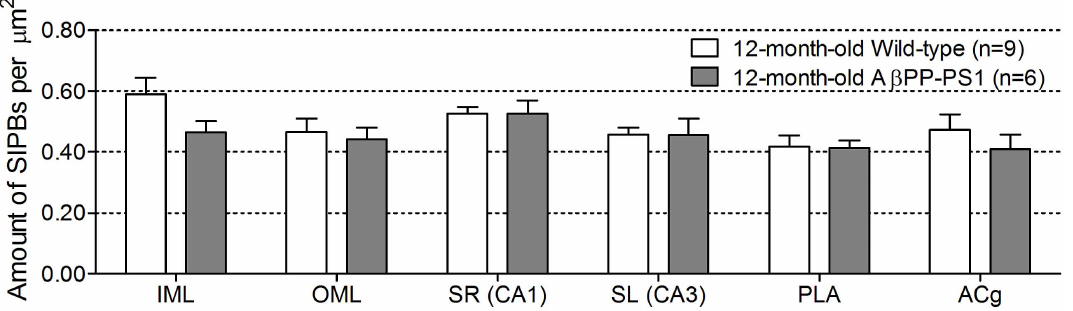
Figure 9. Amount of synaptophysin-immunoreactive presynaptic boutons (SIPBs) per m m 2 in 12-month-old wild-type and A b PP- PS1 mice. The amount of SIPBs were quantified in the hippocampal inner (IML) and outer molecular layer (OML) of the dentate gyrus, the stratum radiatum (SR) of the CA1 area, and the stratum lucidum (SL) of the CA3 area, and in the cortical prelimbic area (PLA) and anterior cingulate gyrus (ACg). No differences in the amount of SIPs between 12-month-old wild-type (n=9) and A b PP-PS1 mice (n=6) were observed in any region analyzed ( p . 0.10).